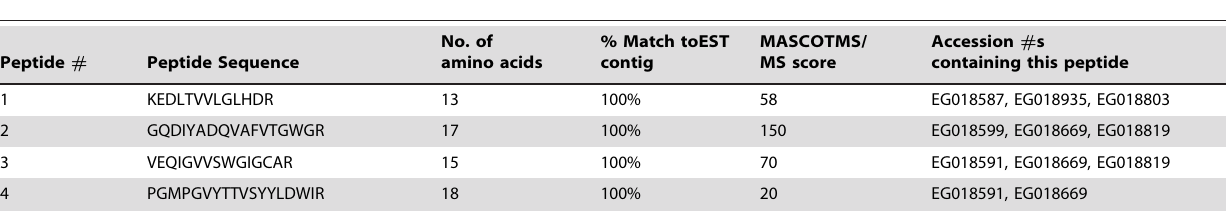
Table 1. Peptides generated with MS/MS analyses and their percent match to an EST contig from the male reproductive accessory gland.